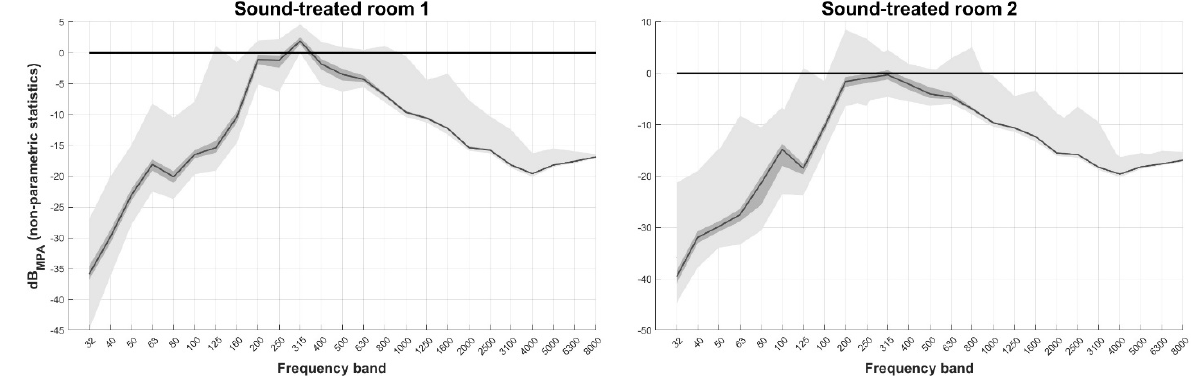
Figure 6. dB MPA non-parametric descriptive statistics of dB MPA per frequency band when typical supra-aural headphones are used in 2 traditional audiometric sound-treated rooms. Black line: median, dark grey area: 1st to 3rd quartile, light grey areas: min to 1st quartile and 3rd quartile to max. dB MPA refers to levels with respect to Maximum Permissible Ambient noise levels when typical supra-aural headphones are used.